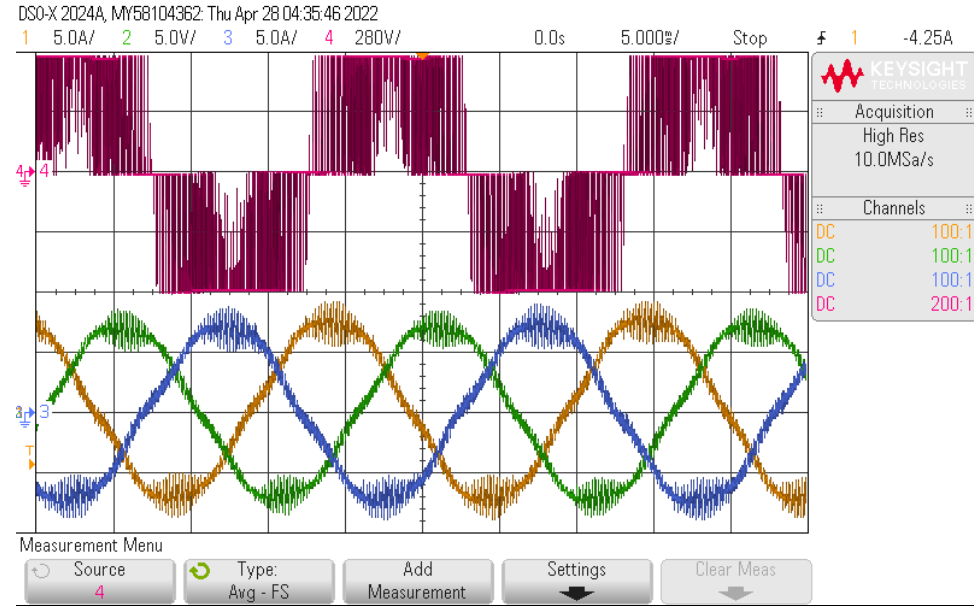
Figure 5. Oscilloscope voltage and current waveforms for the basic HST-SCS [16].